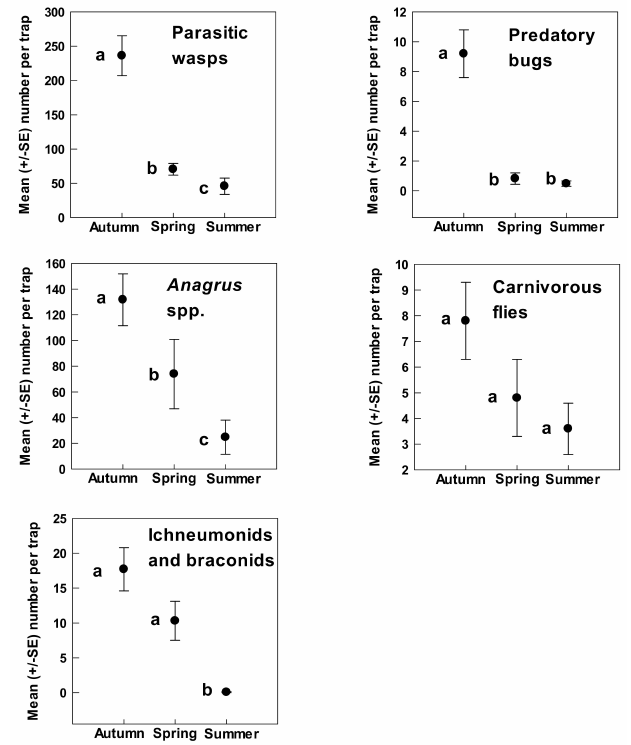
Figure 3. Beneficial insects associated with A. tridentata that showed greatest abundance during fall. Different letters denote significant differences ( p <